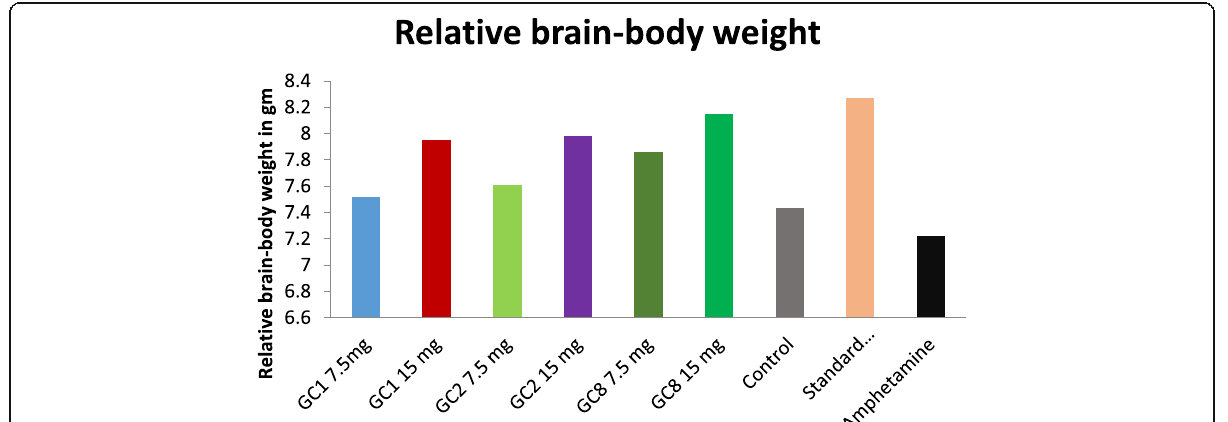
Fig. 3 Relative body weight of Wistar rats on the seventh day of the experiment